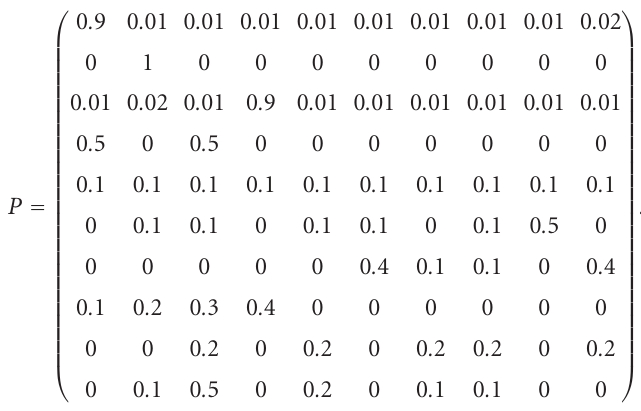
Algorithm 8, the channel capacity per unit cost is 0.5801,